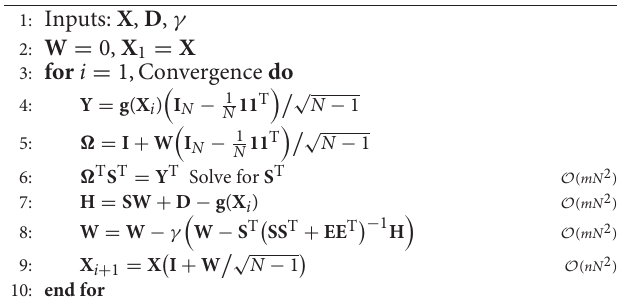
Algorithm 1: Ensemble subspace EnRML